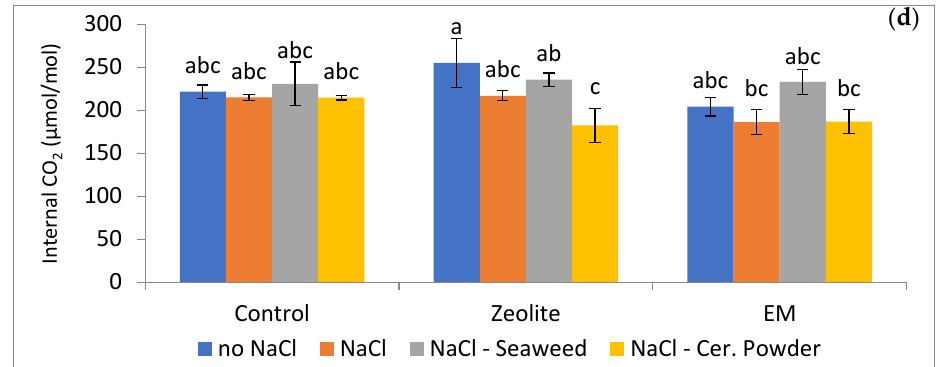
Figure 1. ( a ) Photosynthesis rate, ( b ) stomatal conductance, ( c ) transpiration rate, and ( d ) internal CO 2 concentration in leaves of the apple plants. All the values are averages of four replications ± standard error. The different letters in the same column show statistically significant differences among the twelve subtreatments according to the Duncan test ( p ≤ 0.05) with the larger values corresponding to the letter “a”. I: no NaCl, II: NaCl 50 mM, III: NaCl 50 mM + seaweed extract spraying, IV: NaCl 50 mM + ceramic powder spraying. EM treatment included compost addition.